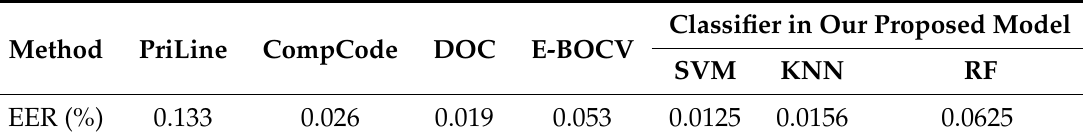
Table 4. Comparison with state-of-the-art methods in terms of EER value for the contact-based HKPU database. CompCode: competitive code; DOC: double orientation code; E-BOCV: extended binary orientation co-occurrence vector; PriLine: principal line.